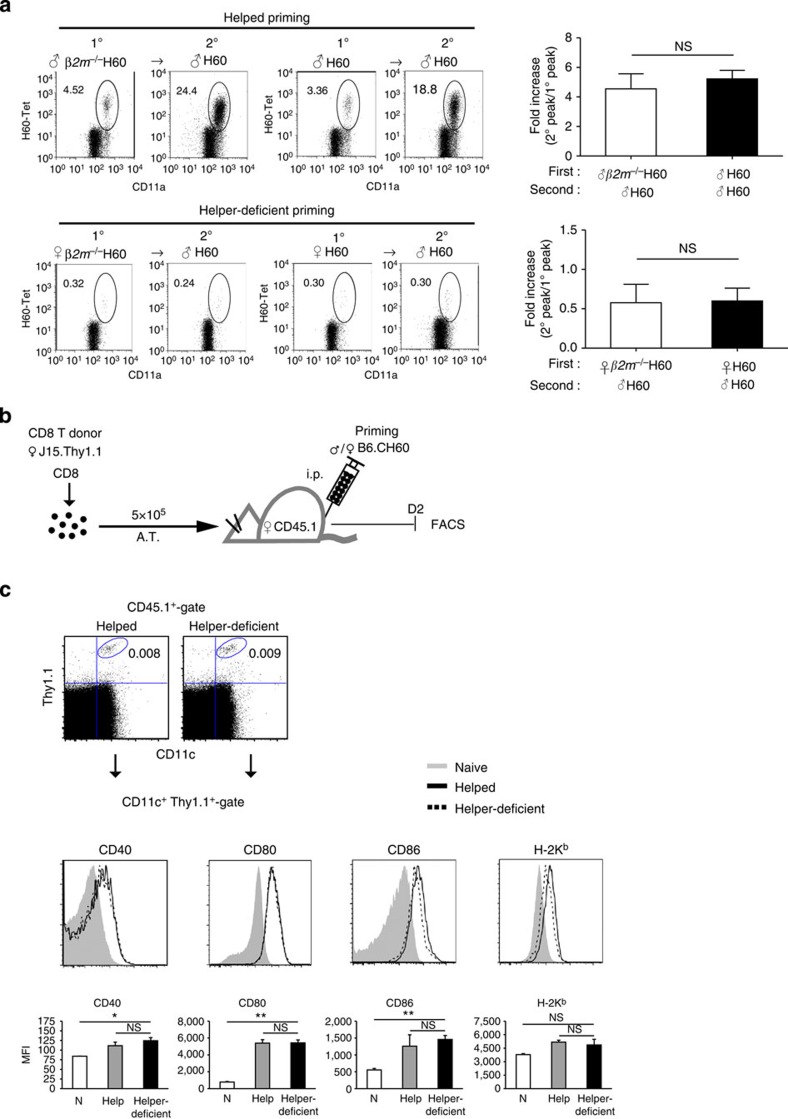
Host APCs participating in helper-deficient CD8+ T-cell activation.(a) Female B6 mice were primed with male or female β2m−/−B6.CH60 splenocytes and boosted with male B6.CH60 cells 40 days later. PBL analyses with H60-tetramer staining were performed longitudinally. The frequencies of the peaks during primary (1o; day 10 post priming) and secondary (2o; day 7 post boosting) responses were compared with those from mice primed and boosted with WT B6.CH60. The fold increases in peak frequencies between the primary and secondary responses were plotted. (b) Schematic presentation of the experimental procedure for analysis of the CD11c+ cells participating in helped and helper-deficient activation of H60-specific CD8+ T cells. Female CD45.1+ B6 mice were adoptively transferred with Thy1.1+ J15 CD8+ T cells (5 × 105) and primed with male or female B6. CH60 splenocytes. Splenic DCs from primed hosts were analysed for expression of co-stimulatory molecules by flow cytometry on day 2 post priming. (c) CD45.1+CD11c+Thy1.1+ cells (host CD45.1+ CD11c+DCs in conjugates with Thy1.1+ J15 CD8+ T cells) were analysed for expression of CD40, CD80, CD86 and H-2Kb. The levels under helped (black bold line) and helper-deficient (dashed lines) conditions were compared with reference to the levels on naive DCs (grey shaded). Average mean fluorescence intensity (MFI) values are plotted. Data are representative of three (a) or two (c) independent experiments (n=3 per group per experiment). A.T., Adoptive Transfer. Data are presented as means±s.e.m. Not Significant (NS) P>0.05, *P<0.05, **P<0.01 determined by Student's t-test.